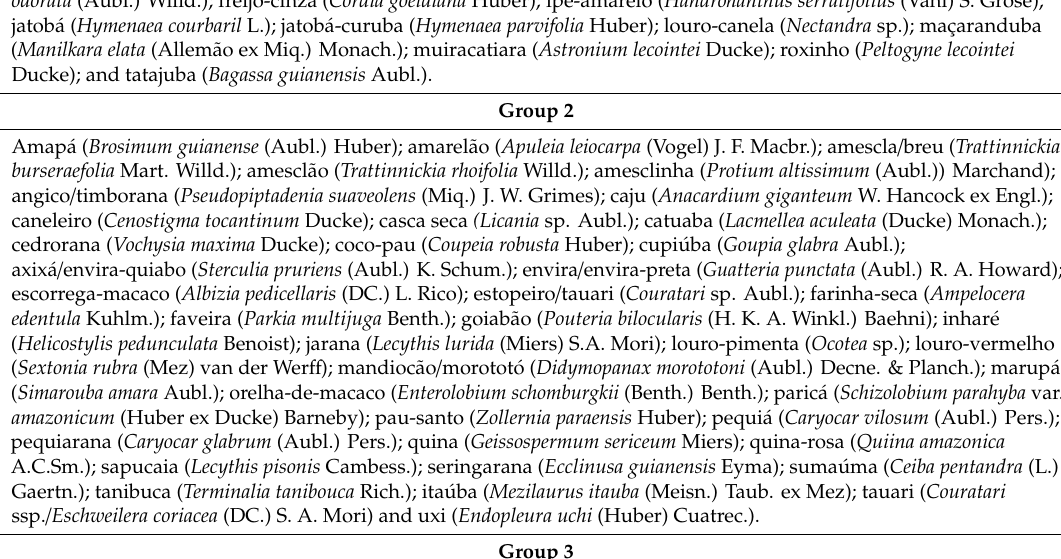
Table 1. Species (commom and scientific name) listed by market value group, forest management area (535.6 ha) at Shet Farm, Dom Eliseu, Par á , Brazil. Group 1